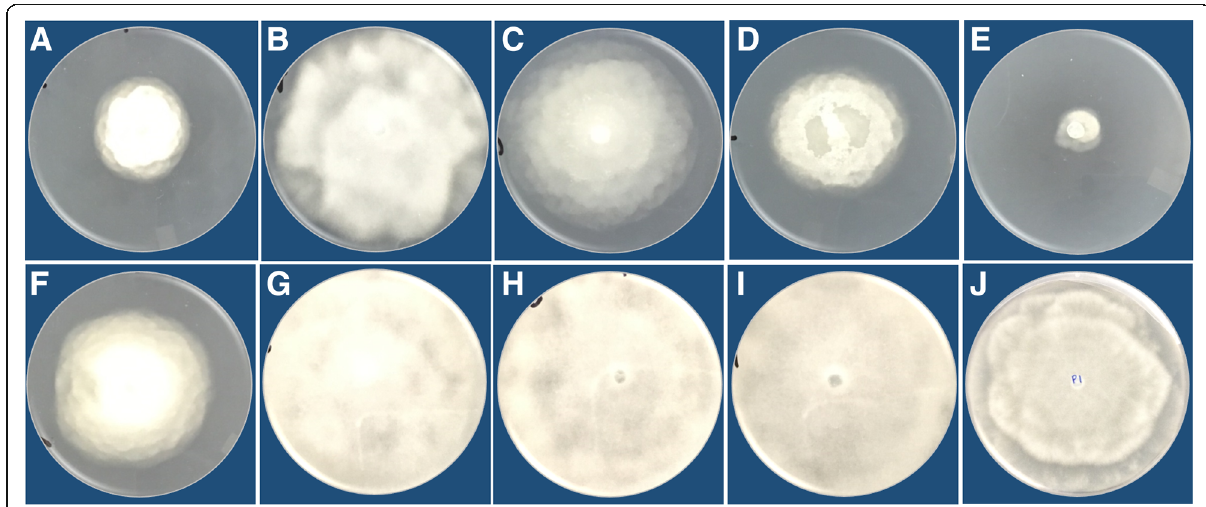
Fig. 3 Colony morphology of Pythium isolates at 3days after incubation on PDA. P. inflatum ( a , e and f ), P. ultimum var. ultimum ( b ), P. orthogonon ( c ), P. torulosum ( d ), P. ultimum var . ultimum ( g ), P. ultimum var . ultimum or P . ultimum var. sporangiferum ( h and i ), and P. irregulare ( j ) incubated under a 12h light/12h dark cycle at